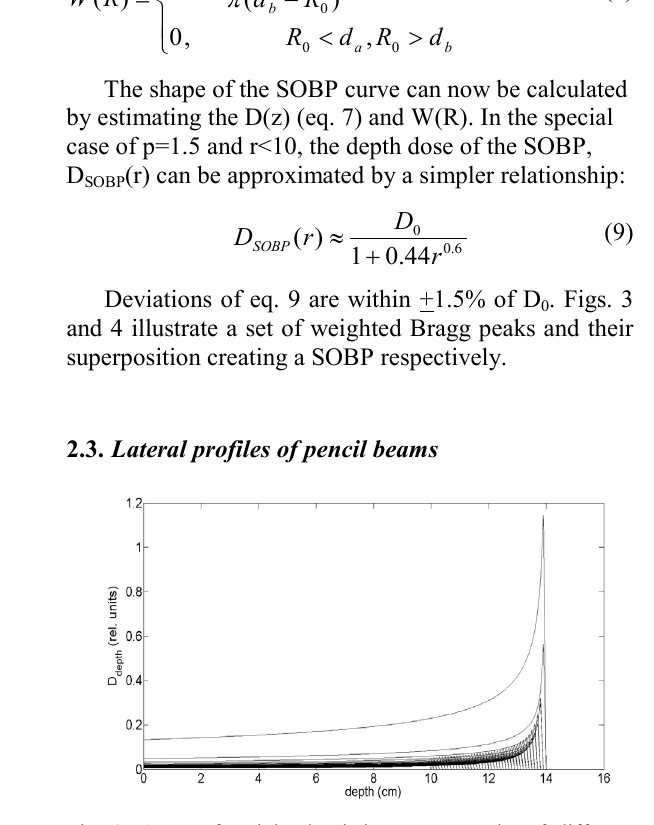
Fig. 3. A set of weighted pristine Bragg peaks of different